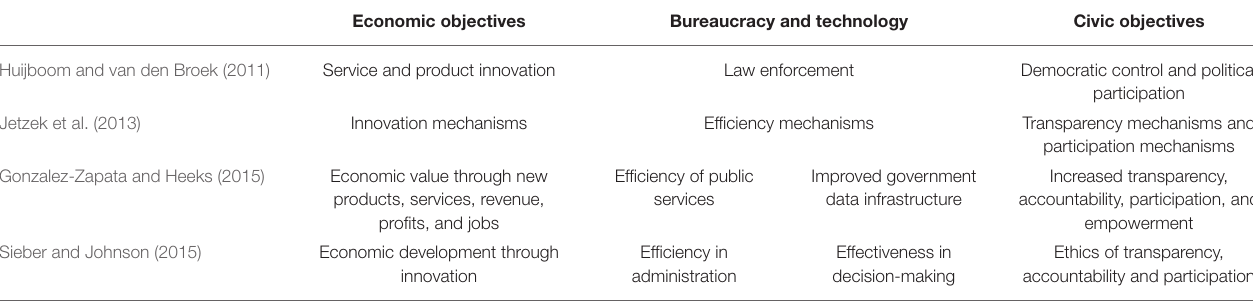
TABLE 1 | Objectives of open data discussed in research